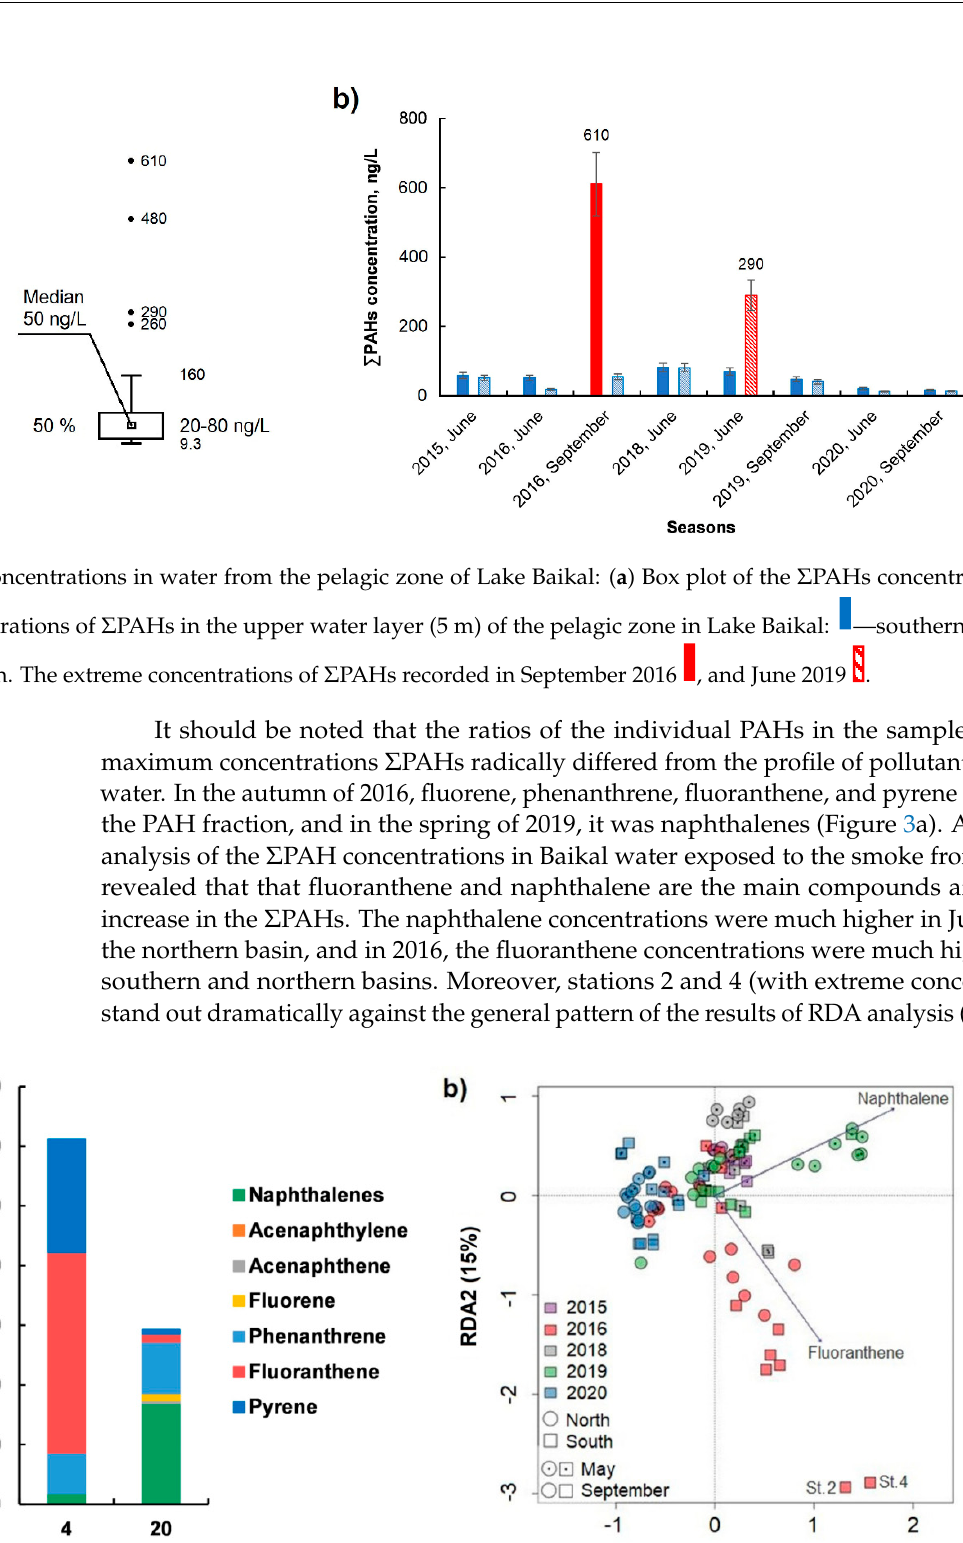
Figure 3. ( a ) The PAH ratio in the extracts of water samples: St. 4 - southern basin, September 2016; St. 20 northern basin, June 2019; ( b ) RDA analysis of the PAH compositions in different water samples by sampling site, year, and month.